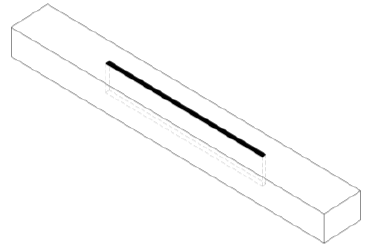
Figure 6. Method proposed in References [37,38].